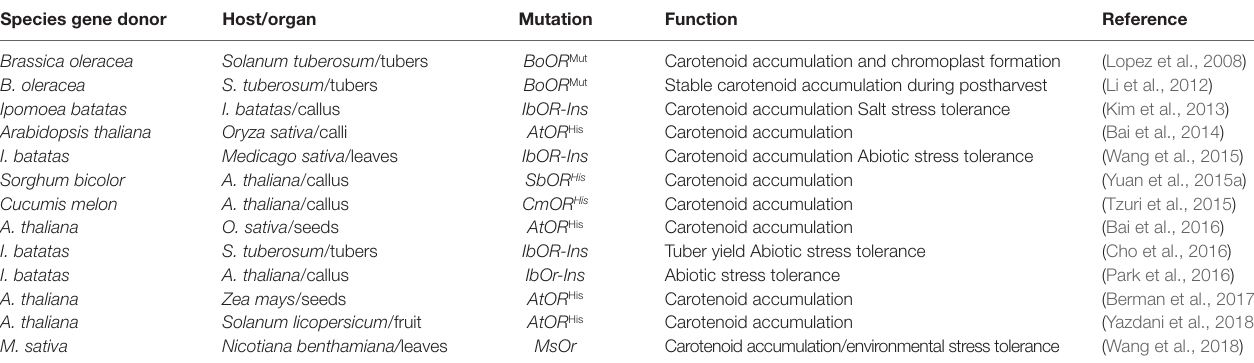
TABLe 1 | Effect of Orange gene on carotenoid expression in higher